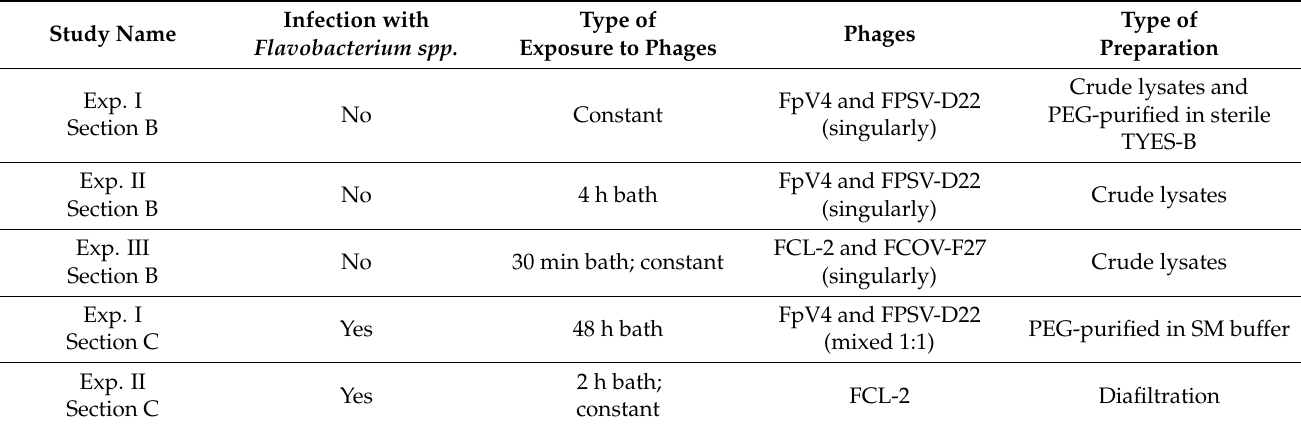
Table 1. Overview of studies focused on exploring the interactions between rainbow trout eyed eggs and Flavobacterium spp. bacteriophages (section B and